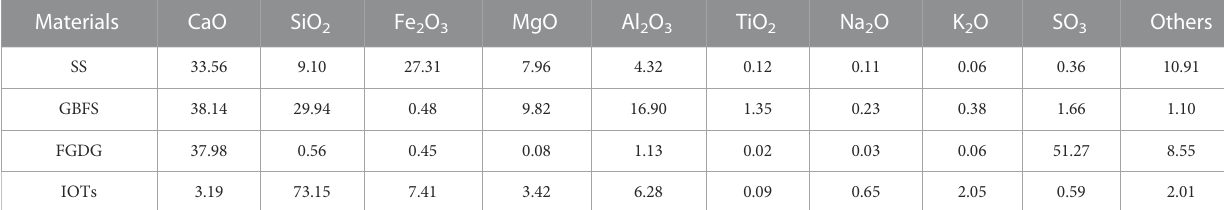
TABLE 1 Chemical composition of raw materials (mass fraction, %). Materials